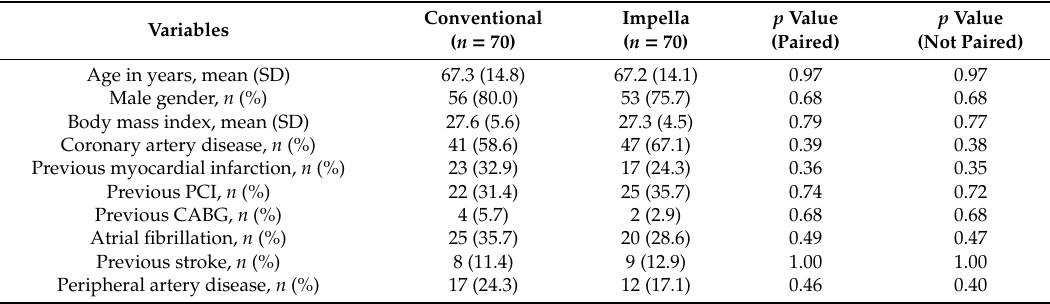
Table 1. Baseline characteristics of matched patients.